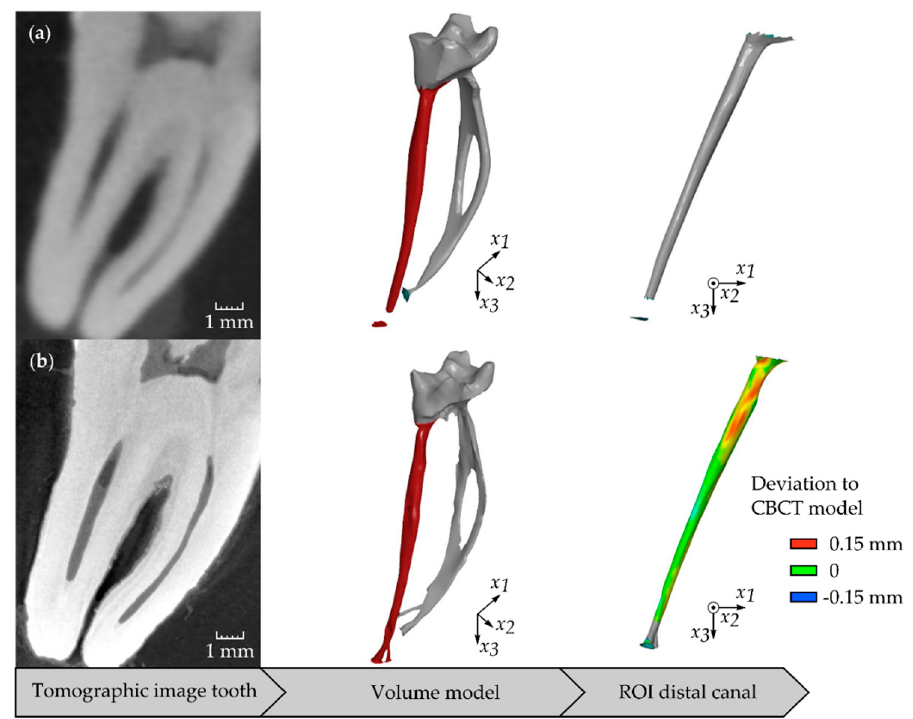
Figure 1. Buccolingual view of a mandibular first molar taken by topographical imaging techniques, the resulting volume model of root canal morphology from three-dimensional imaging data and its distal root canal: ( a ) CBCT, ( b )